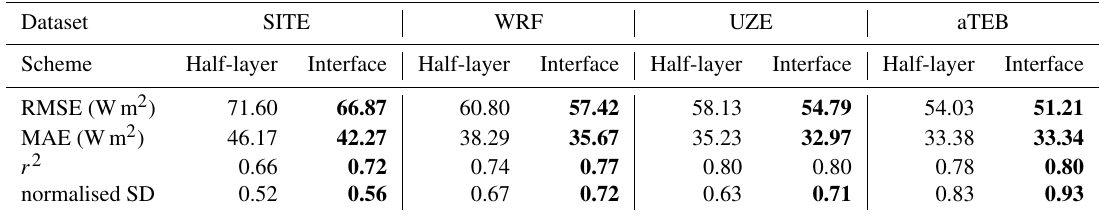
Table 2. aTEB half-hourly performance statistics for (cid:49)Q S : different conduction schemes (improvement in bold).